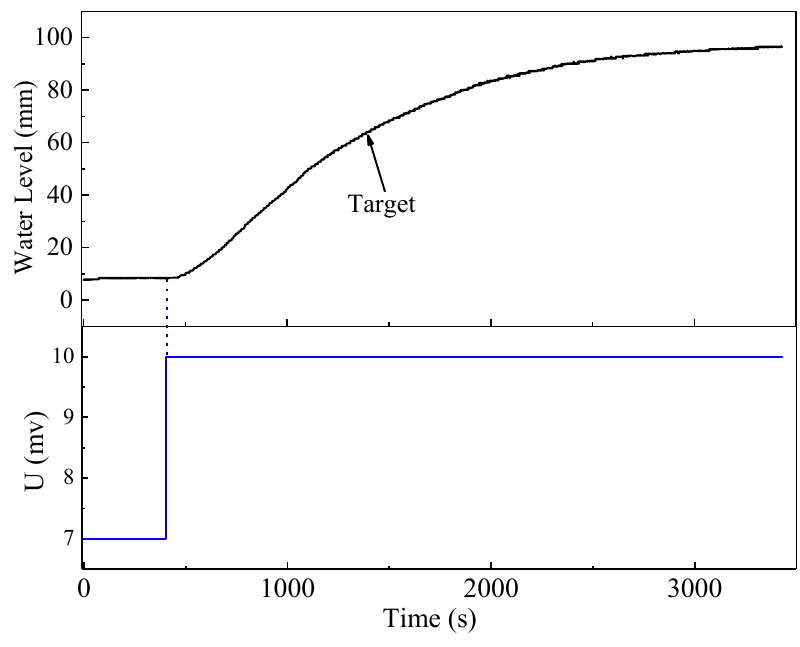
Figure 7. Open-loop step response.